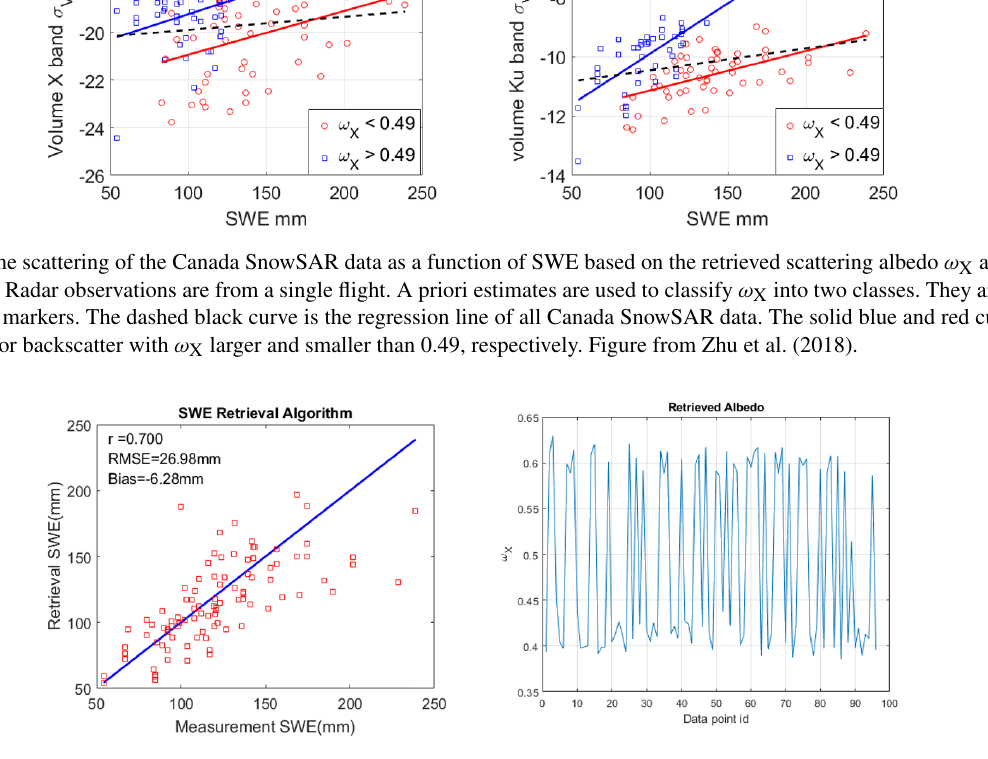
Figure 15. (a) SWE retrieval performance and (b) scattering albedo retrieval using Canadian SnowSAR 2013 X- and Ku-band radar data. The figures are from Zhu et al. (2018) and Zhu